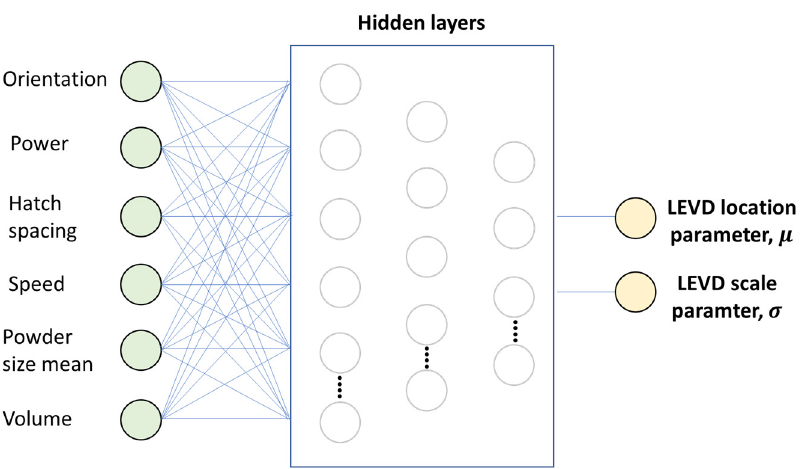
Figure 3. ML algorithm which provides in output the location and the scale parameters of the LEVD of (cid:3493)𝑎 (cid:3030) for a given set of process parameters and risk-volume.